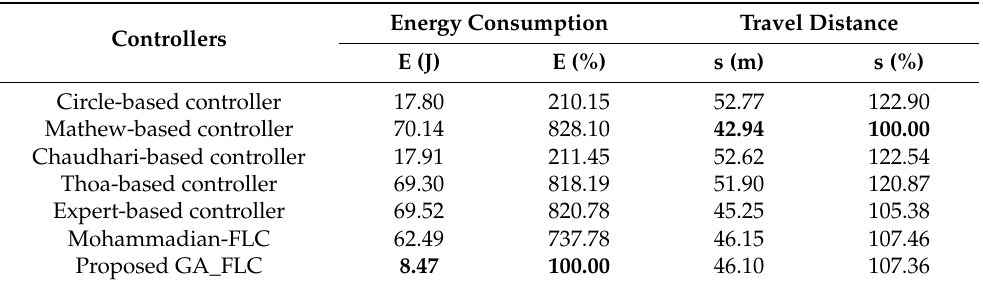
Table 11. Energy consumption and travel distance of the robot when the robot tracks the zigzag path by the different controllers. Bold values are the best in the appropriate column.